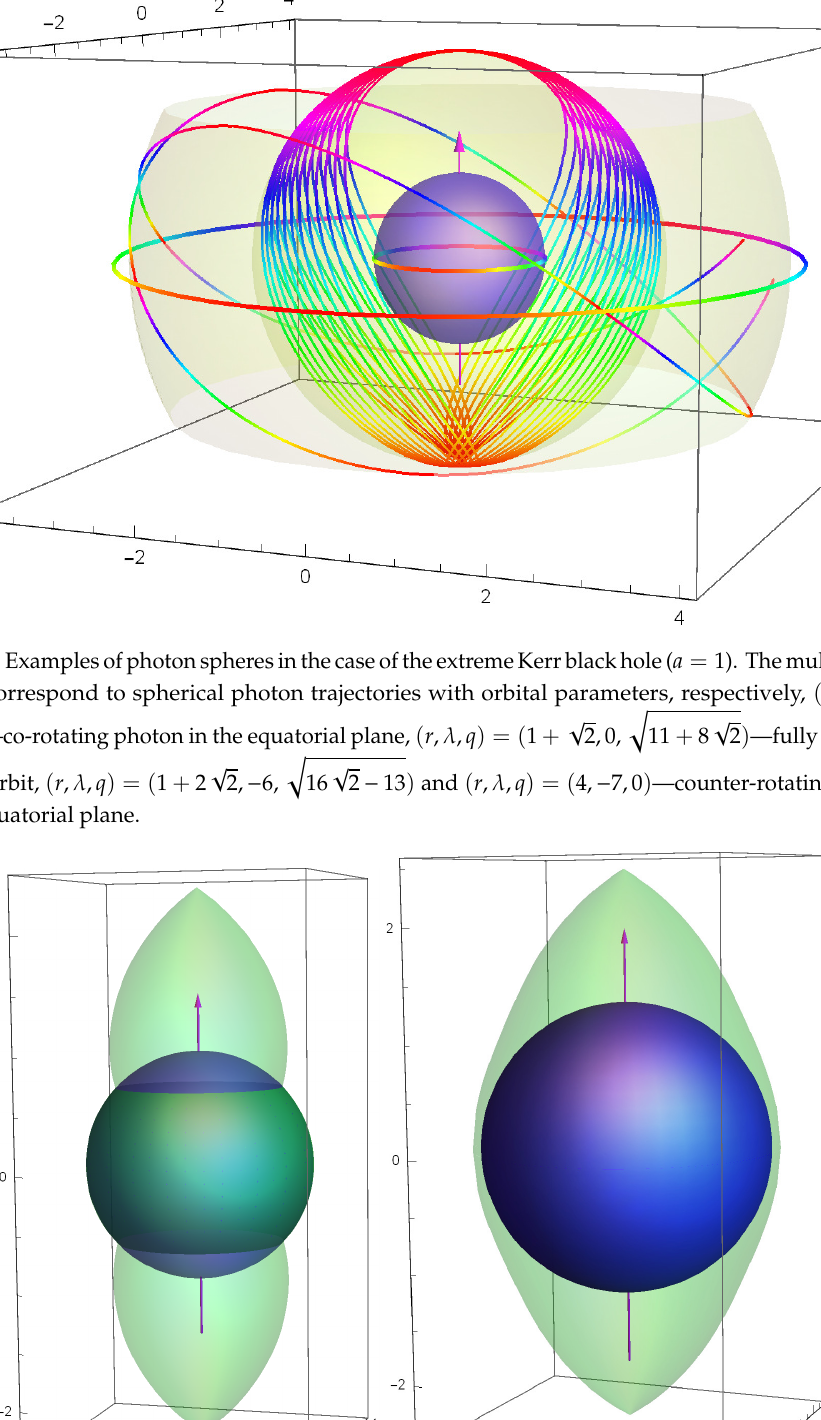
Figure 6. Envelopes of photon spheres with λ ≥ 0 (closed green regions) in the case of Kerr black holes with spin a = 1 ( left panel ) and a = 0.95 ( right panel ). In the case of extreme Kerr black hole ( a = 1) there are skimming photons, which are move both in the azimuth and latitude directions on the sphere with radius r = 1 by oscillating in polar directions with 0 ≤ cos [ θ min ] ≤